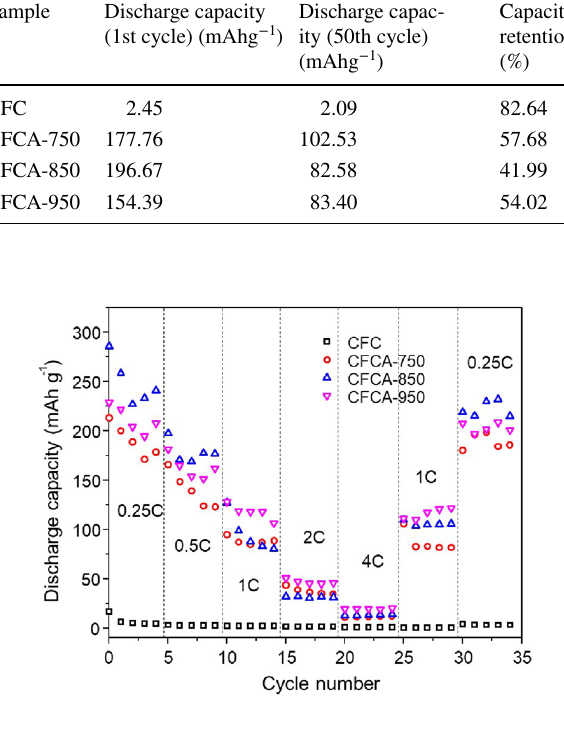
Fig. 9 Rate capability of CFC and